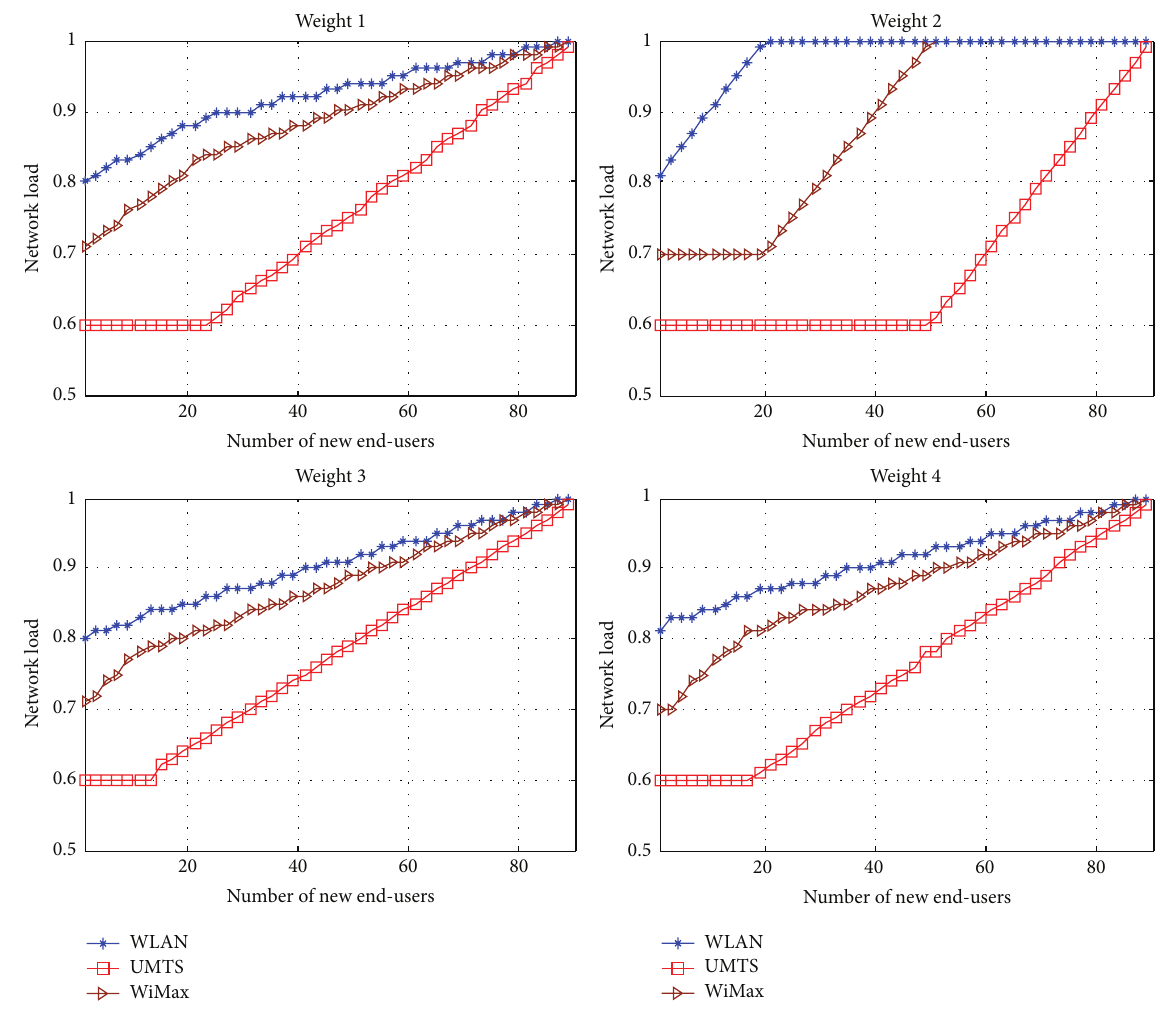
Figure 5: Change of network load by MEW.